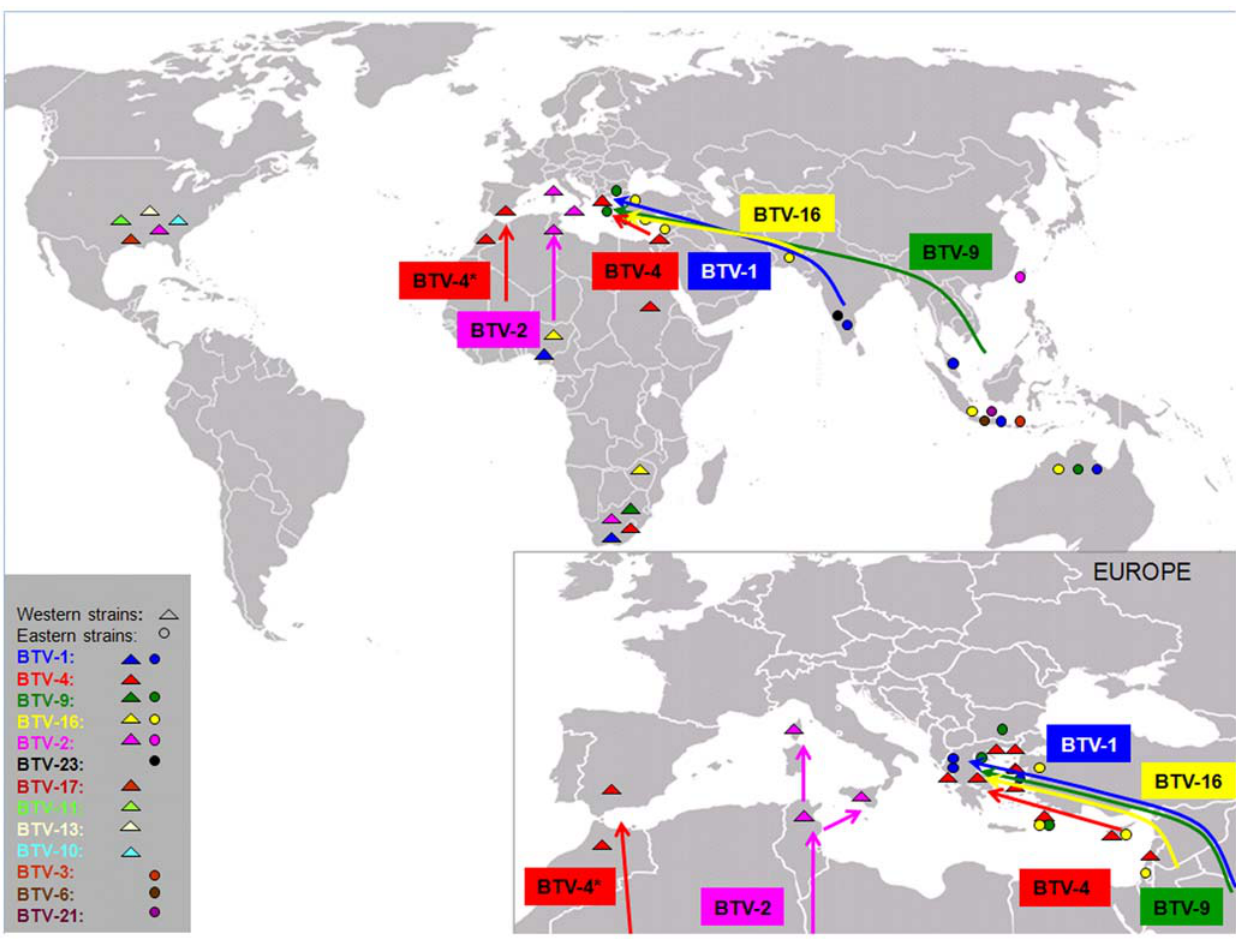
Figure 1. Map of geographical location of the isolates analysed in this study and the sources of BTV incursions in Europe.